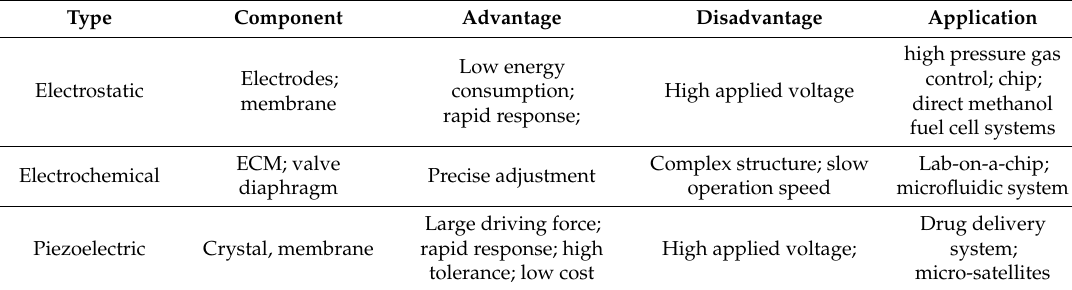
Table 2. Comparisons of three types of electrically actuated